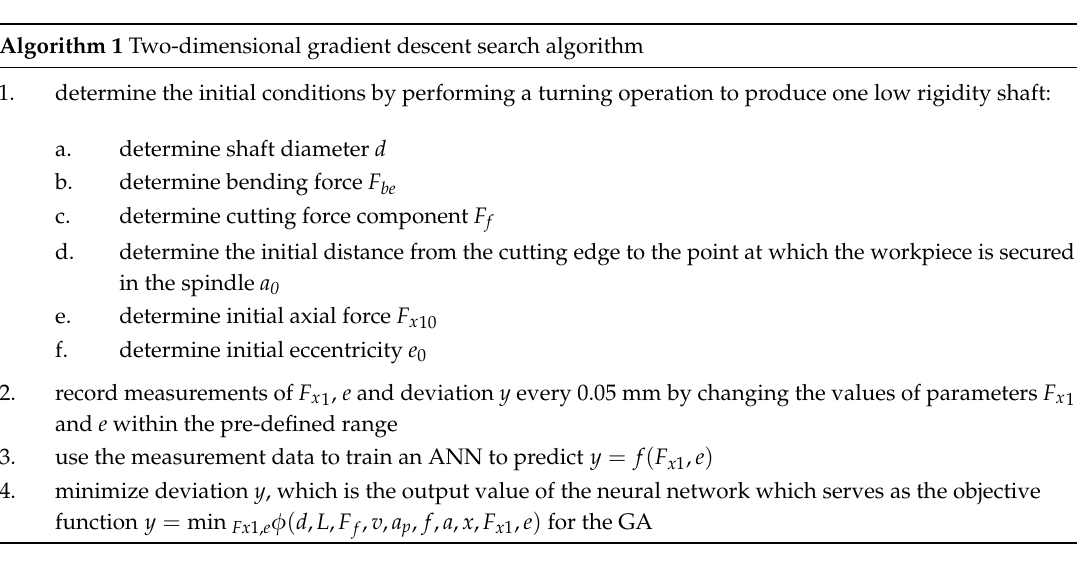
Figure 6. Curves of objective function y, tensile force Fx 1 , and eccentric e for d = 8 mm, F be = 147 N, Fx 10 = 980 N, L = 300 mm, F f = 196 N.